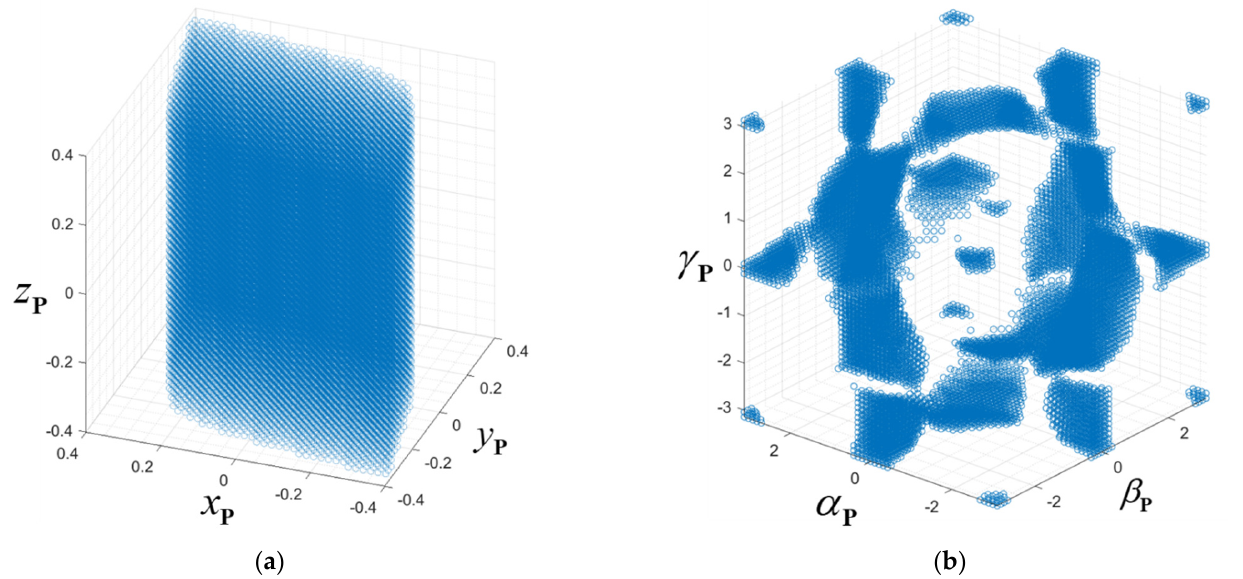
Figure 8. Wrench closure workspace of the second configuration shown in Figure 1. ( a ) constant orientation WCW with α P = 0, β P = 0 and γ P = 0.052 rad; ( b ) constant position WCW with x P = 0, y P = 0 and z P = 0.